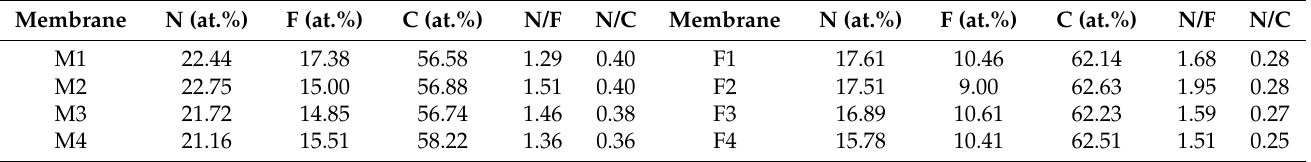
Table 2. Elemental ratios of N/F and N/C of the synthesized membranes.